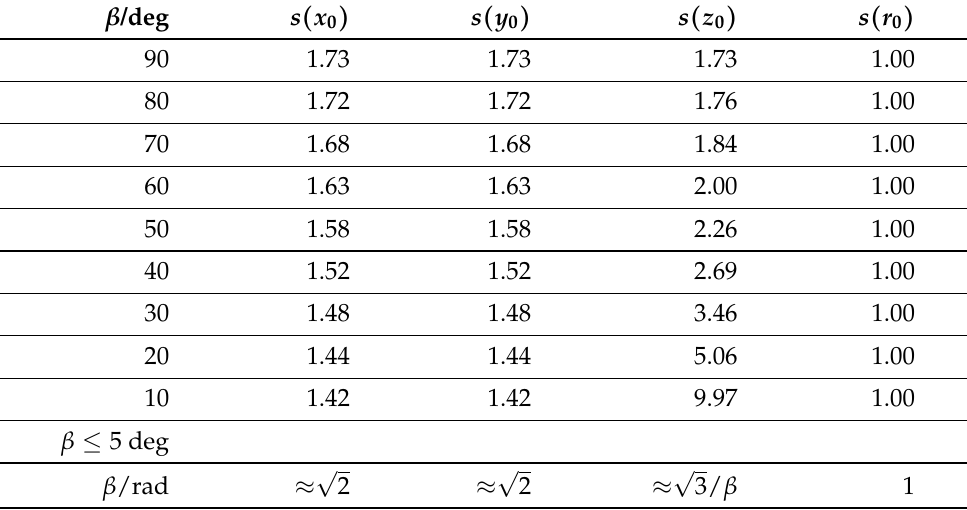
Table 3. Equatorial band of a sphere. Square roots s ( a ) of the diagonal elements of V β in (19). For points x 1: m approximately uniformly distributed on an equatorial band of the sphere with elevation angle satisfying − β ≤ φ i ≤ β ≤ π /2 and for point-cloud variance matrix σ 2 √ u ( a ) = σ R s ( a ) / m